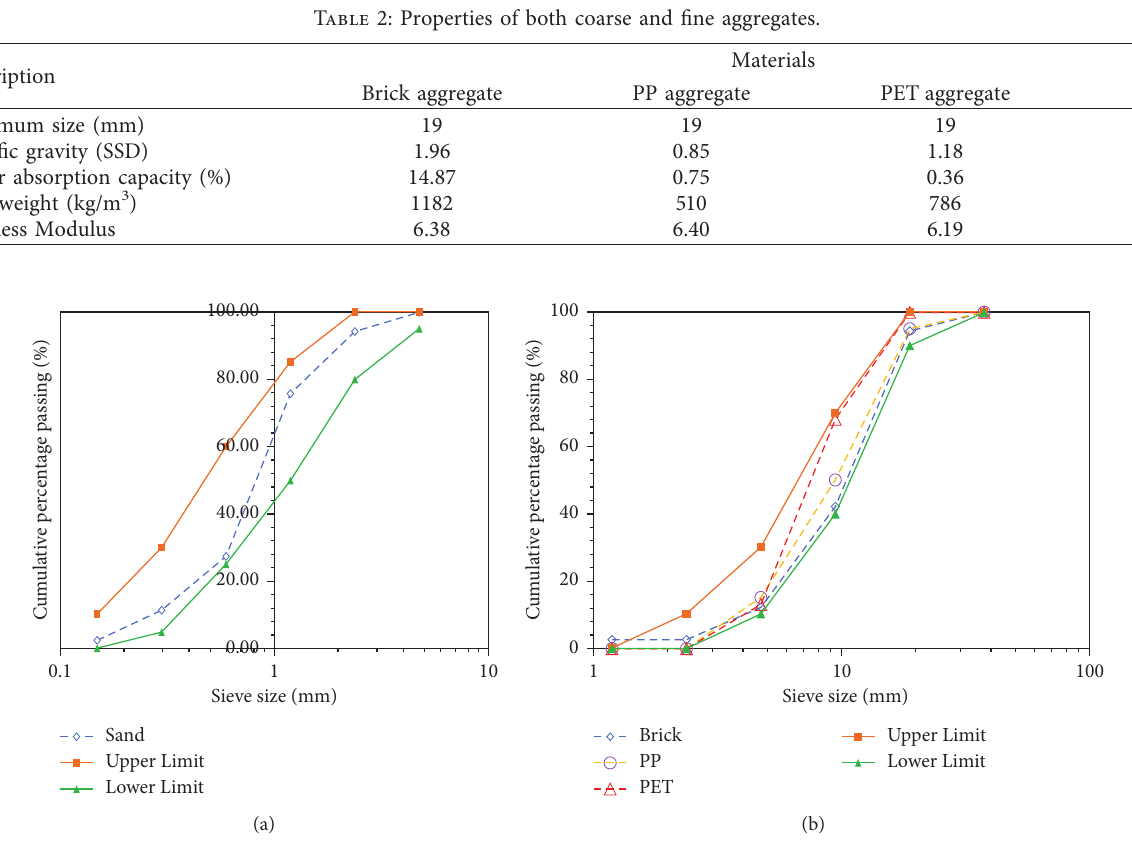
Figure 1: Grading size distributions of (a) fine aggregates and (b) coarse aggregate along with ASTM limits.